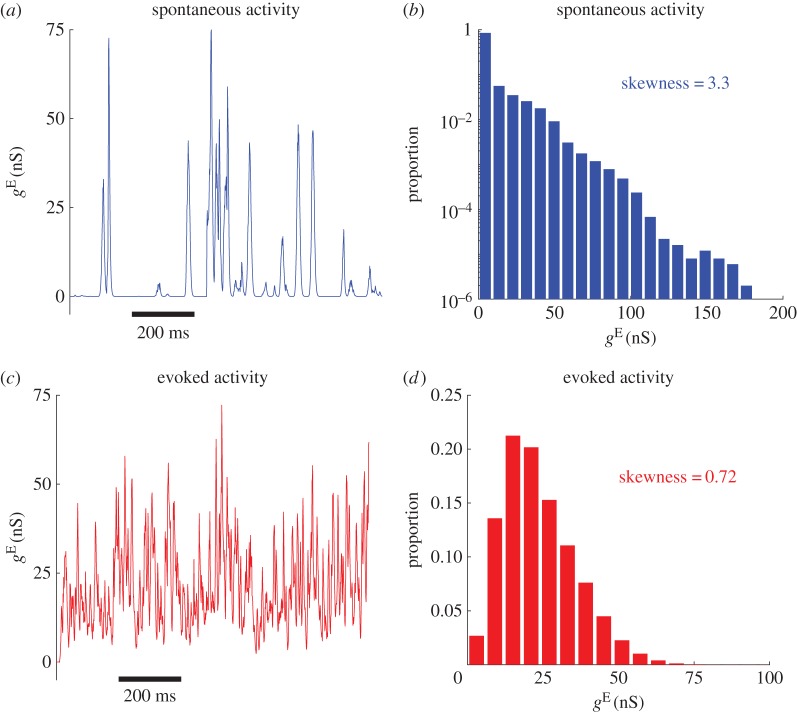
Properties of synaptic inputs to neurons during the spontaneous and evoked activity. (a) Time series of the excitatory conductance gE received by a randomly chosen neuron within the RoI during the spontaneous activity; it consists of quiescent activity punctuated by large, occasional excursions in conductance. (b) Histogram of the excitatory conductance gE received by the neuron during the spontaneous activity, aggregated across all trials; it is heavy-tailed, as emphasized by the use of logarithmic scaling for the y-axis, with a skewness value of 3.3. (c) Time series of the excitatory conductance gE received by the neuron after stimulation; it consists of continuous fluctuations about a mean. (d) Histogram of the excitatory conductance gE received by the neuron across all trials after stimulation; it more closely resembles a Gaussian, with a skewness value of 0.72.